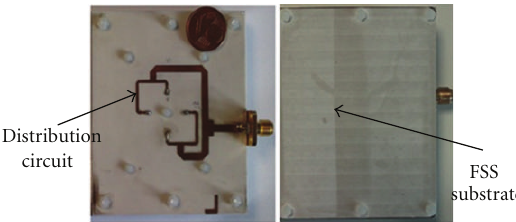
Figure 7: Bottom (left) and top (right) views of the manufactured prototype.